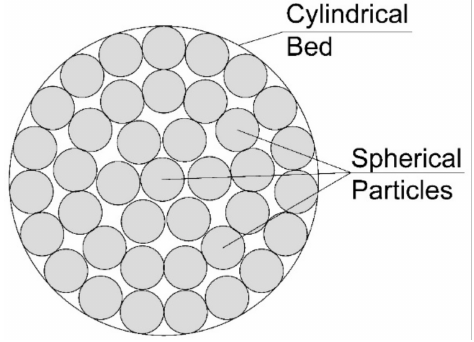
Figure 1. A Spherical packed bed (SPD)